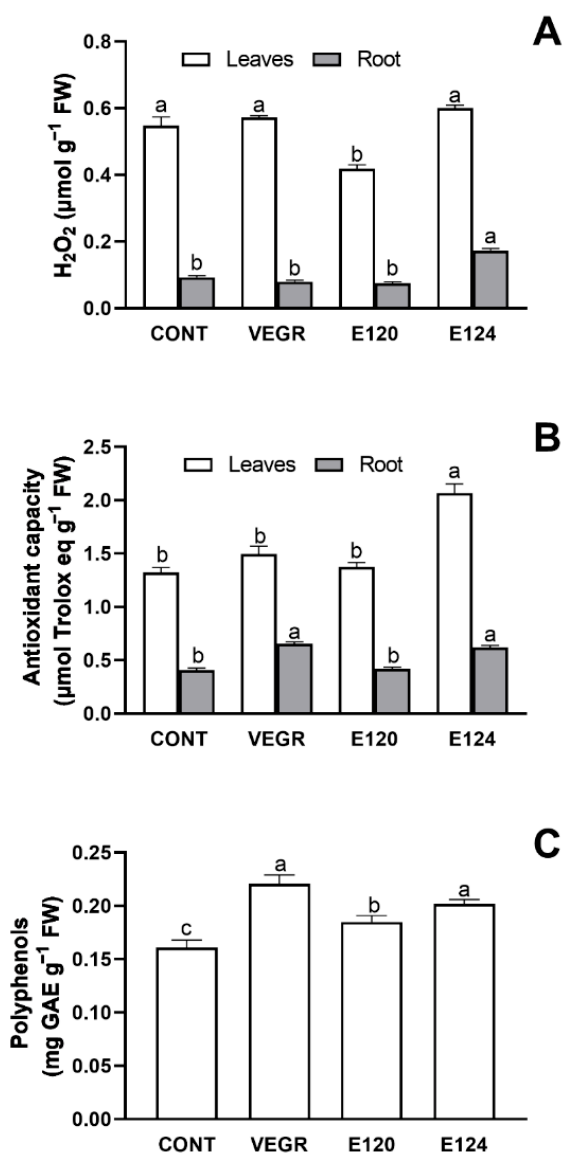
Figure 3. H 2 O 2 concentration ( A ) and antioxidant capacity ( B ) in leaf and root, and total polyphenols in leaf ( C ) in C. sativus control seedlings (CONT) and seedlings treated with different food dyes (VEGR, E120, and E124). Values are means ± SEM ( n = 10). Different letters indicate statistically significant differences among treatments.